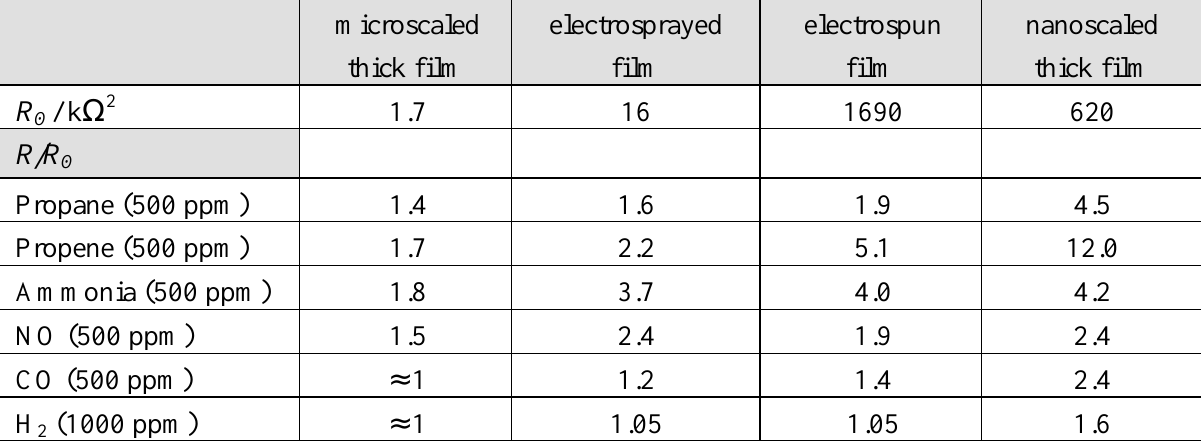
Table 1: Comparison of SrTi nanotechnology. R/R obtained at 400 °C in dry